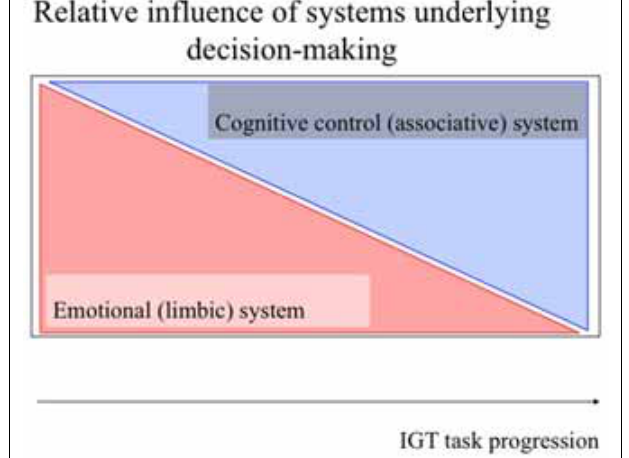
FIGURE 1 | Schematic model of the role of different systems in task-progression in the IGT. The horizontal axis represents the progression of the task, while the vertical axis represents relative activity. The upper and lower triangle represent the relative contribution of the different brain systems which may be involved in the different stages of the test: learning relevant task-relevant features (emotional (limbic) system; transparent red), and consistently directing behavior toward choosing cards from the long-term advantageous decks [cognitive control (associative) system; transparent blue, see text for further